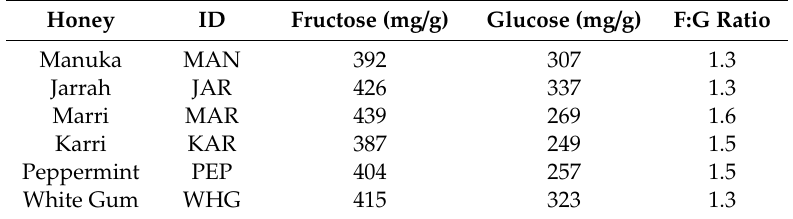
Table 1. Fructose and glucose content, and fructose to glucose ratio (F:G) of honeys 1 .